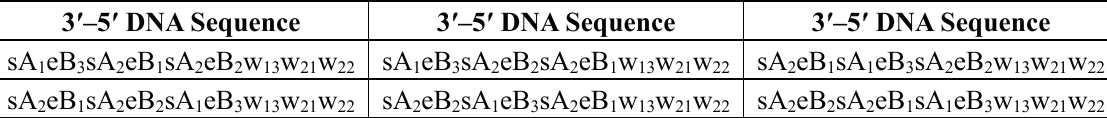
Table 7. DNA Sequences symbols after Step (5) for Table